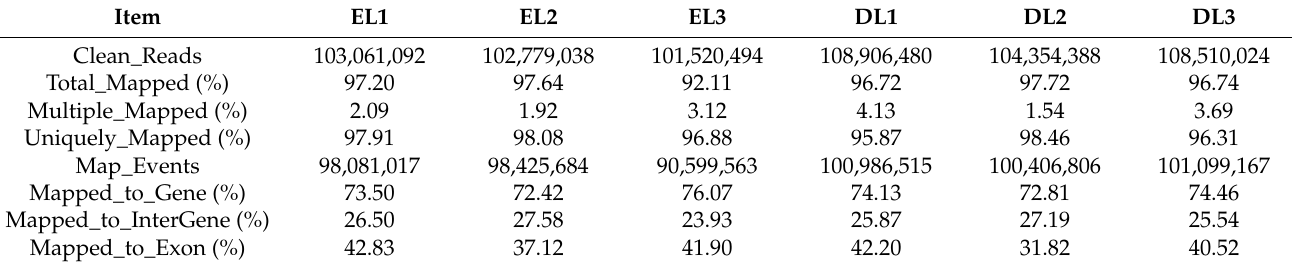
Table 2. Mapping statistics and events of RNASeq.